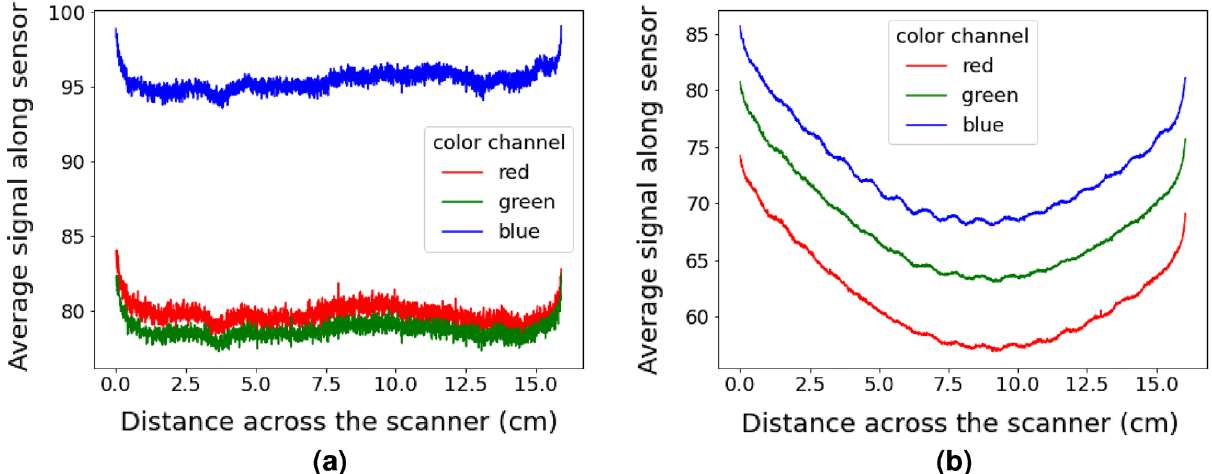
Figure 1. Comparison of the signal from the blue channel averaged across the wafer in the scanners direction of movement. Each dot represents the average signal measured by a different pixel for ( a ) a CIS and ( b ) non-CIS scanner.